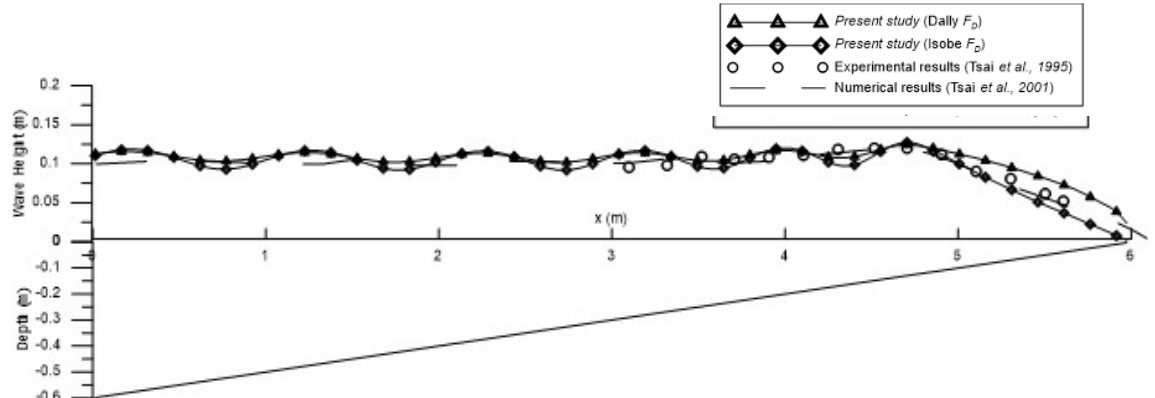
Figure 9. Wave heights for breaking and dissipation of waves by a slope of 1/10 with various formulas of energy dissipation factors [25,27,28,44].